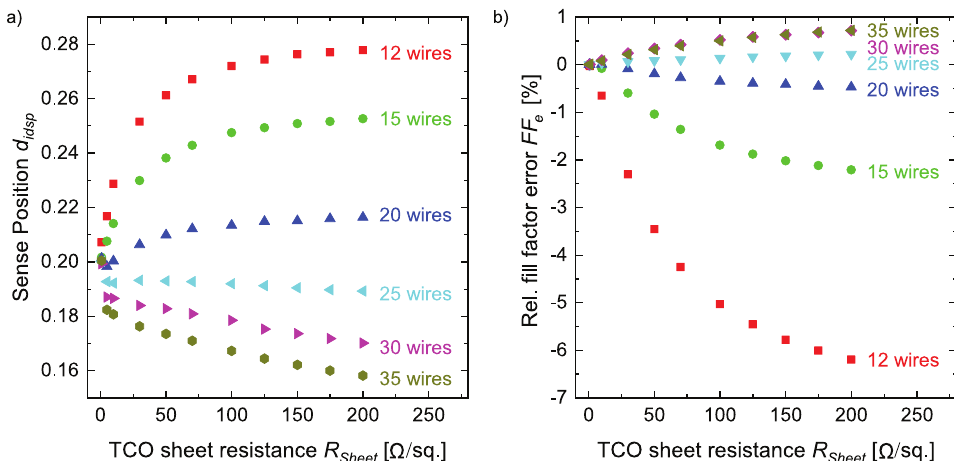
Fig. 6. (a) Simulated relative position of the voltage sense contact for a grn FF measurement depending on the TCO sheet resistances. (b) Relative error FF e of the fi ll factor measurement when placing the sense contact at d sp =0.2 depending on number of wires used for contacting and sheet resistance of TCO.